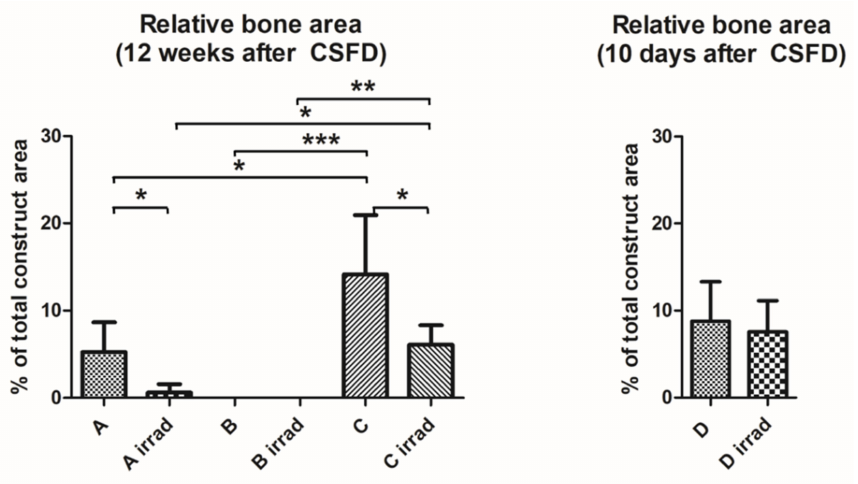
Figure 4. Relative bone area in constructs after 12 weeks (group A/A irrad, B/B irrad, C/C irrad) and 10 days (group D/D irrad). Bone formation was significantly impaired in group A irrad, compared to group A (* p ≤ 0.05). No bone formation was noted in constructs filled with hydroxyapatite scaffold alone (B/B irrad). Compared to the short-term groups (D/D irrad), the relative bone area increased in unirradiated defects (group C), whereas cessation of ossification occurred in irradiated bones (C irrad). This led to a significantly higher relative bone area in group C compared to group C irrad (* p ≤ 0.05). The implantation of hydroxyapatite/BMP-2/MSCs led to a significantly higher ossification than in empty defects or defects filled with hydroxyapatite alone, both with and without irradiation (* p ≤ 0.05; ** p ≤ 0.01, *** p ≤ 0.001). Values are given as mean ±